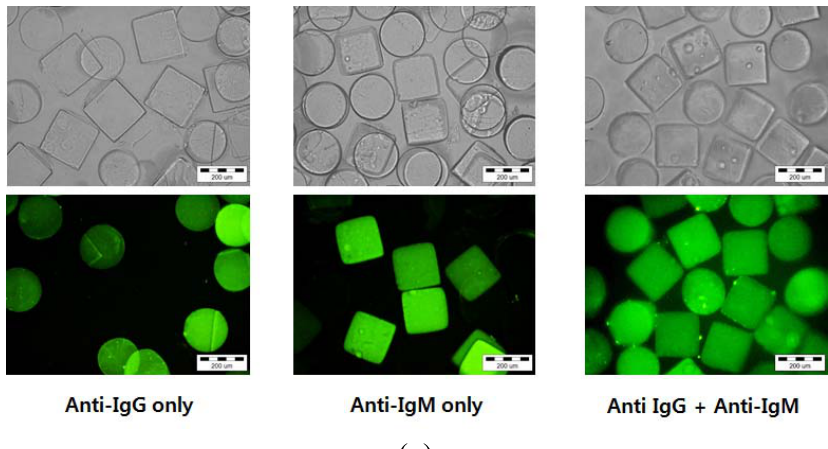
5. Multiplexed immunoassays using shape-coded hydrogel